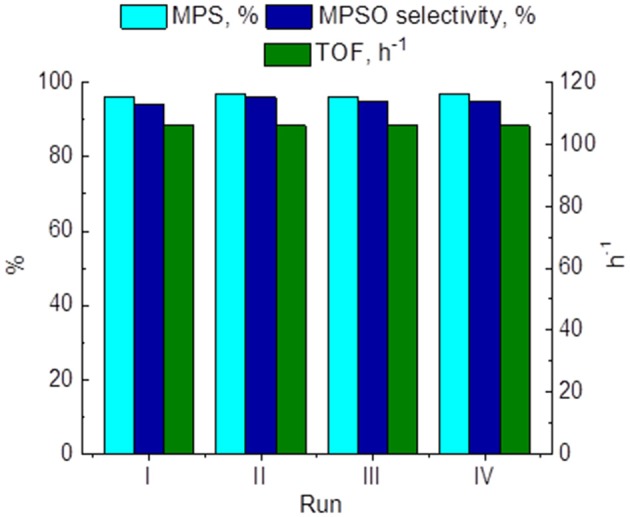
Recycling performance of 15 wt. % PW4/CNTs in MPS oxidation. Reaction conditions: [MPS] = 0.1 M (11.7 μl), [H2O2] = 0.1 M (10 μl), 15 wt. % PW4/CNTs, 15 mg (1 μmol PW4), MeCN 1 ml, 27°C.